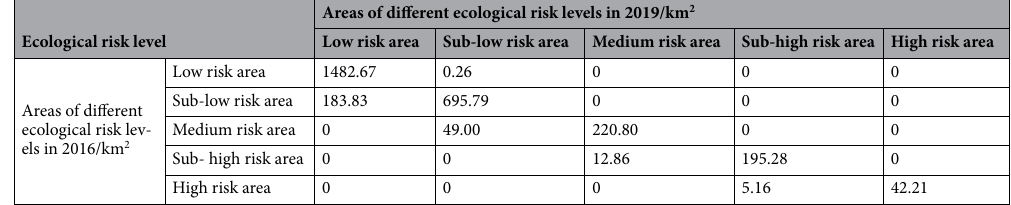
Ecological risk level